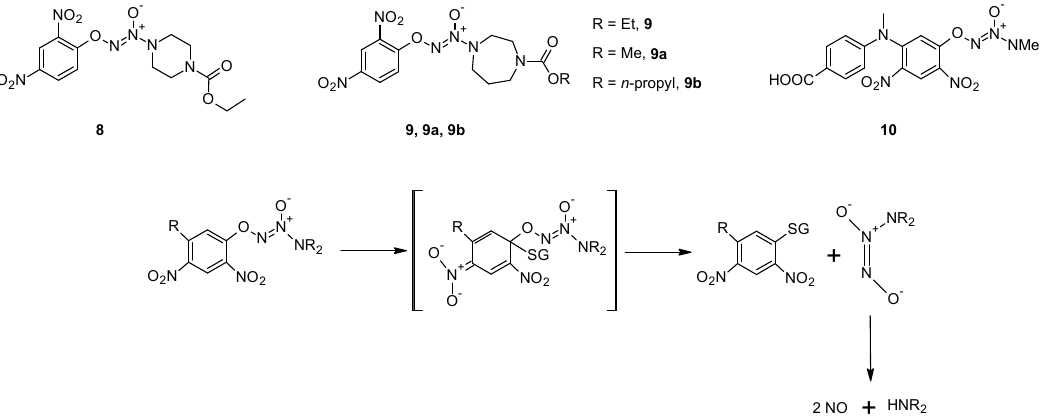
Figure 4. Chemical structures of compounds 8 , 9 and 10 , and mechanism of nitric oxide